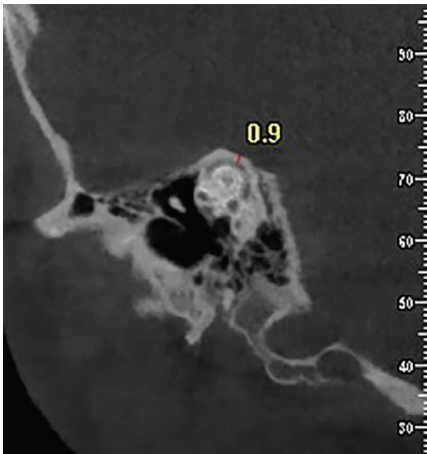
Figure 1: Te thinnest part of the superior semicircular canal (SSC) coverage was measured as the SSC